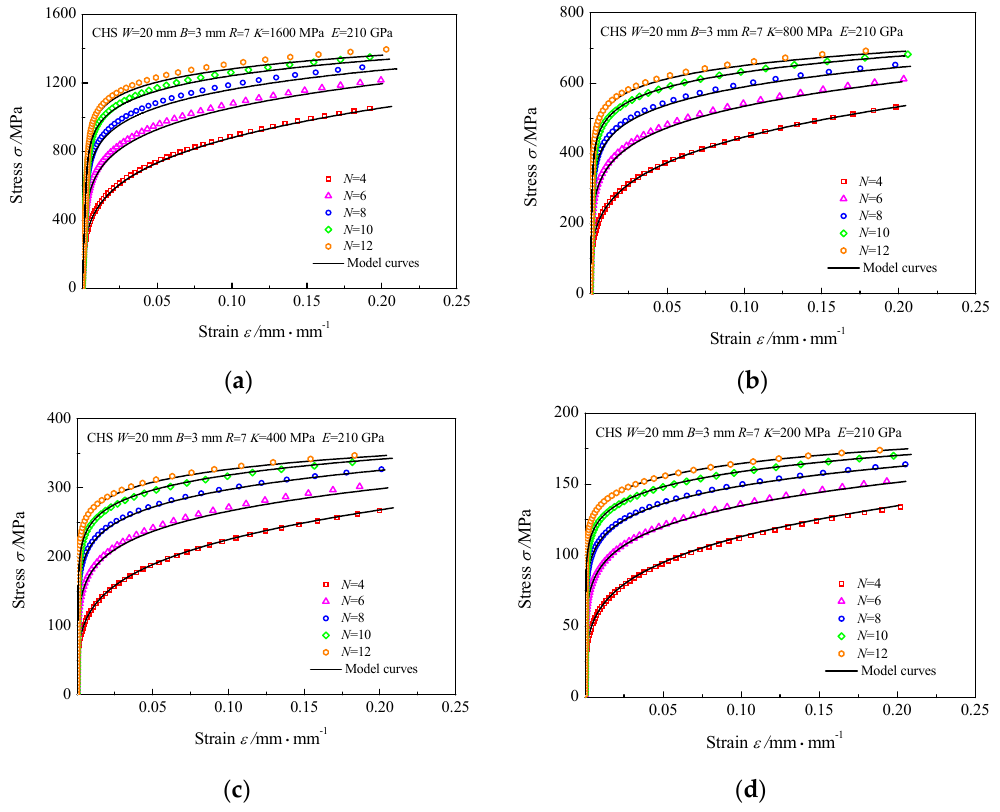
Figure 9. Predicted uniaxial stress-strain curves of materials , ( a ) K = 1600 MPa E = 210 GPa; ( b ) K = 800 MPa E = 210 GPa; ( c ) K = 400 MPa E = 210 GPa; ( d ) K = 200 MPa E = 210 GPa.